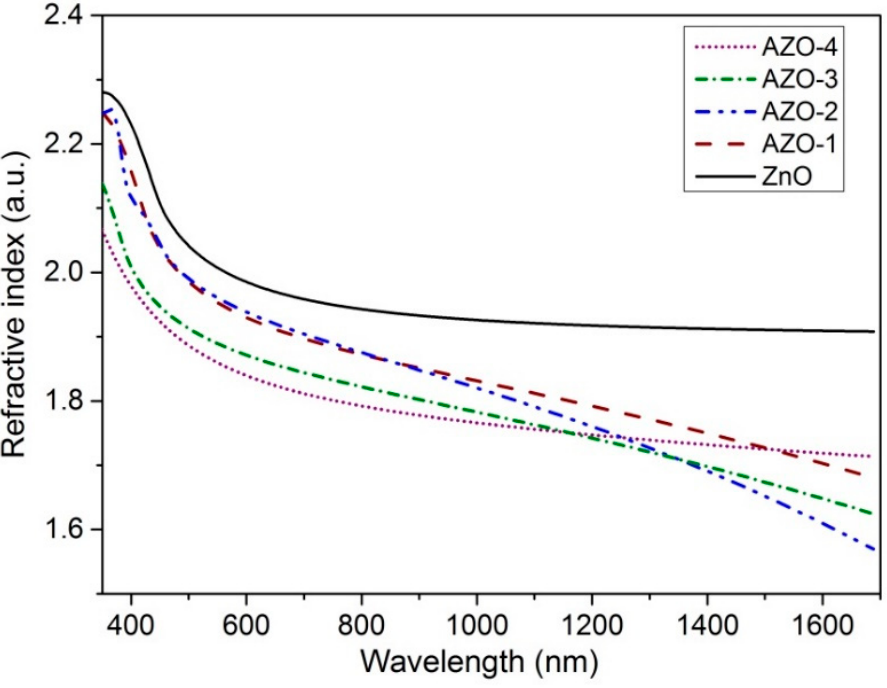
Figure 7. Spectral dependence of refractive index for samples with different contents of aluminum, from ellipsometric measurements (SE) using the general oscillator (GO) model. The transmission spectra of ZnO and AZO1–4 films were also measured by use of a Perkin-Elmer spectrophotometer (T–R measurements). The obtained results are presented in Figure 8. All films were transparent with the average transmission in the visible light region (~85%). The absorption edge shifted towards higher energies with the increase of Al content, as we already reported previously